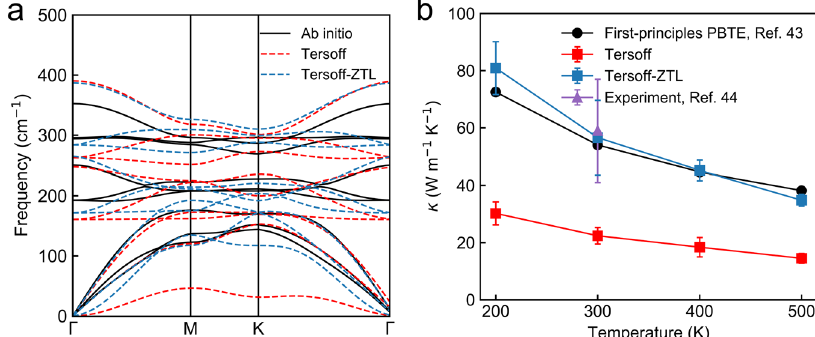
Fig. 6 Transferability test for the parameterized Tersoff potentials (Tersoff and Tersoff-ZTL) on thermal properties of monolayer MoSe 2 . a Phonon dispersion predicted by the Tersoff potential in comparison to ab initio results. b Thermal conductivity predicted by the Tersoff potential in comparison to fi rst principle calculations by solving the Peierls-Boltzmann transport equation (PBTE) 43 , as well as experimental measurements on suspended monolayer MoSe 2 using optothermal Raman techniques 44 . The Tersoff-ZTL corresponds to the parameterized potential with the training data of “ Tersoff ” plus the three acoustic phonon modes, i.e., ZA, LA, and